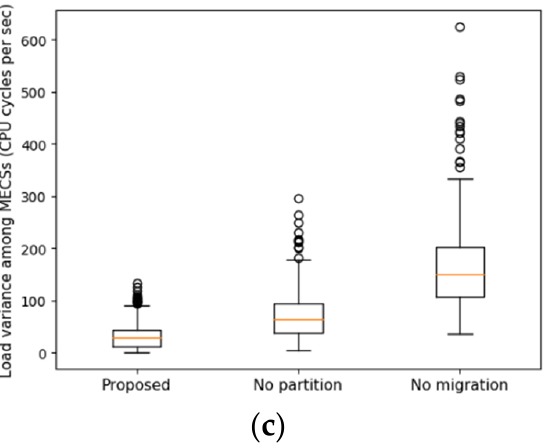
Figure 4. Load variance among MECSs of the three methods; ( a ) vehicle arrival rate = 0.3; ( b ) vehicle arrival rate = 0.6; ( c ) vehicle arrival rate = 0.9.